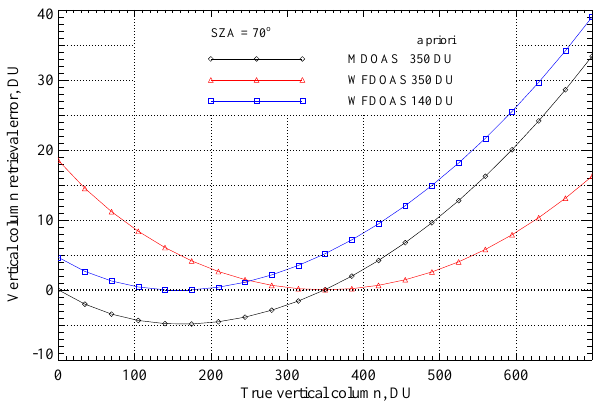
Fig. 5. Same as in Fig. 4 but for a solar zenith angle of 90 ◦